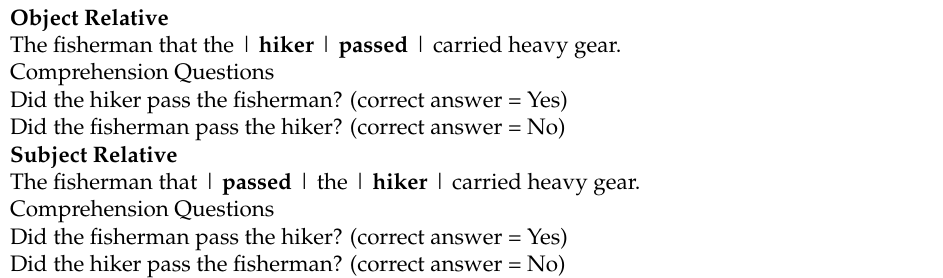
Table 1. Example stimuli showing object- and subject-relative clauses, and comprehension